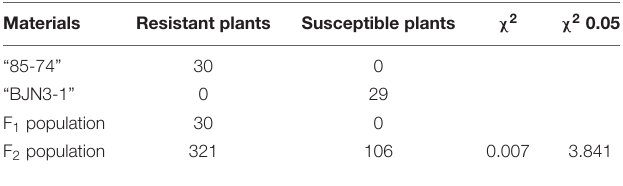
TABLE 2 | Genetic analysis of clubroot resistance in the F 2